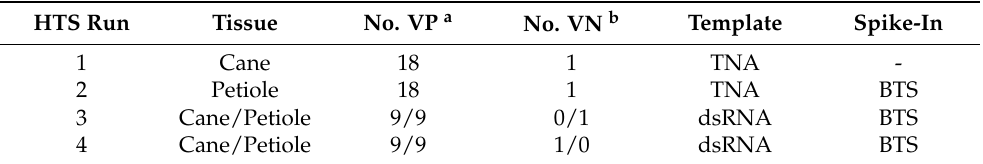
Table 2. Description of the HTS runs used in a broad evaluation of both TNA and dsRNA extraction methods on both spring canes and fall petioles. Where indicated, common bean cv Black Turtle Soup (BTS) was added as a positive control.